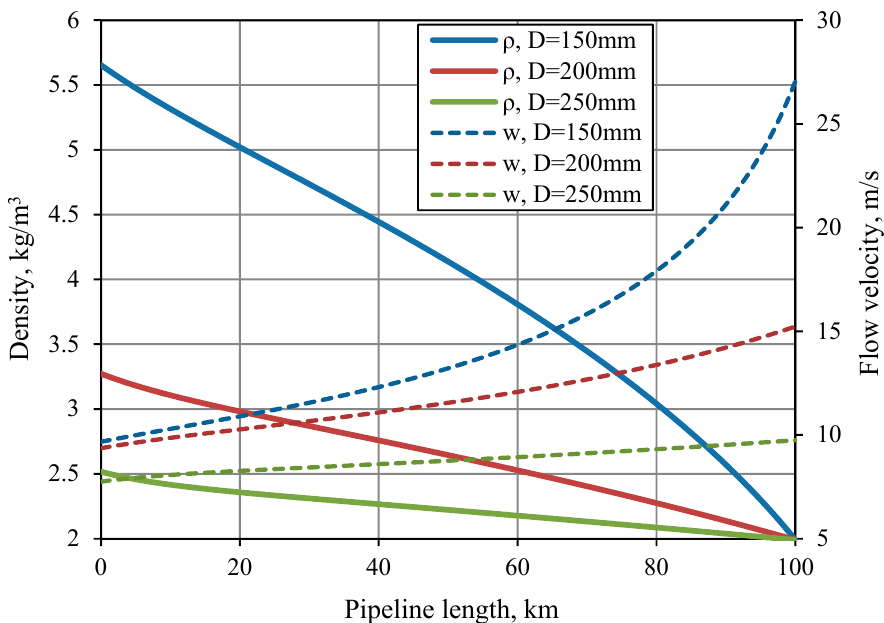
Figure 10. Density ( ρ ) (continuous lines) and flow velocity ( w ) (dashed lines) changes for hydrogen mass flow rate 1.0 kg/s (40,000 Nm 3 /h).